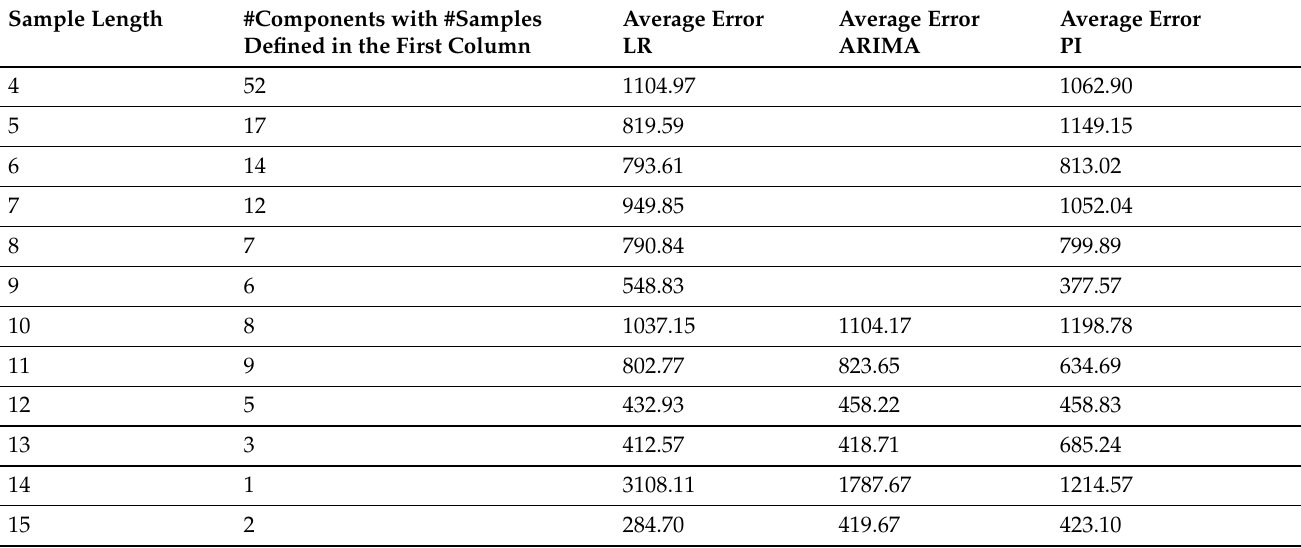
Table 14. Distributions of errors per model and per components with the same number of